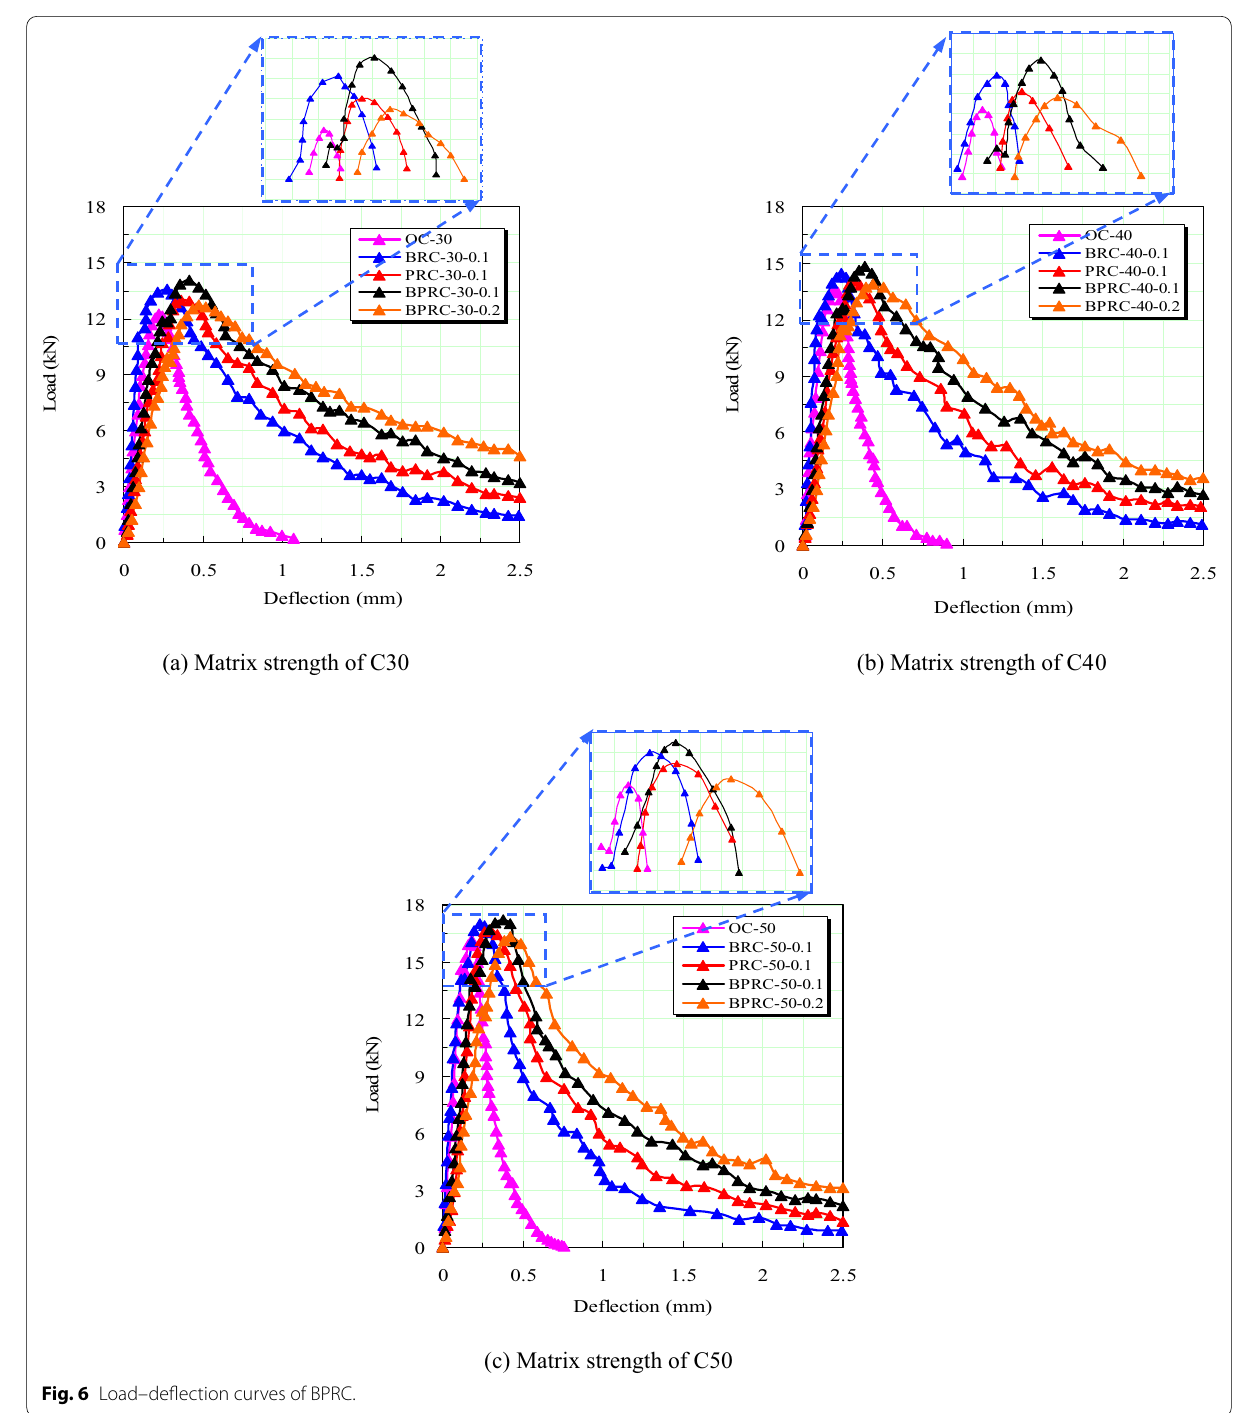
Fig. 6 Load–deflection curves of